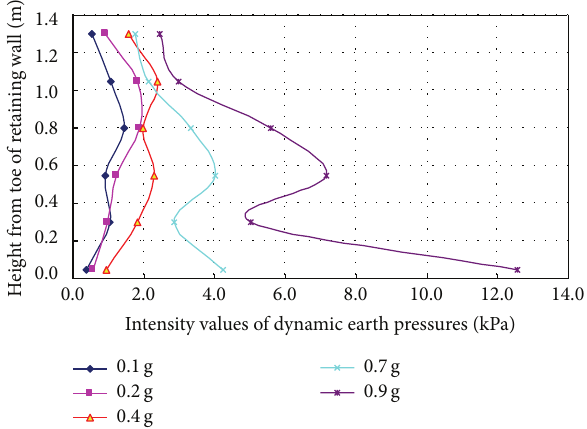
Table 2: Location of resultant earth pressure of embankment retaining wall on rock foundation ( ℎ / 𝐻